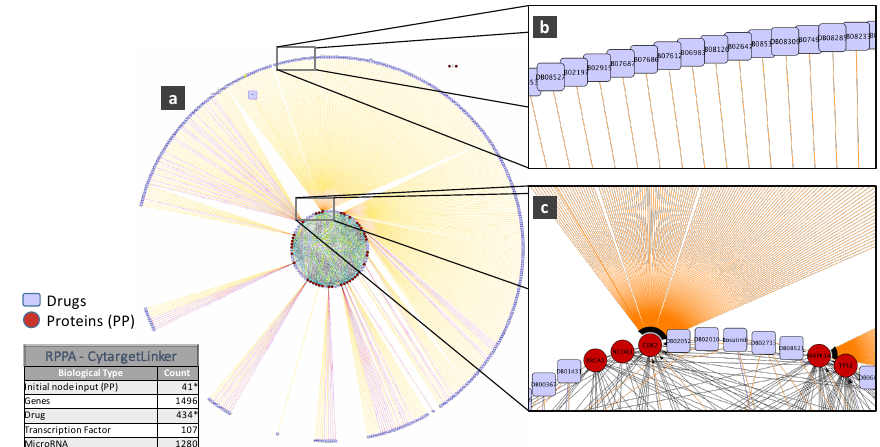
Figure 6. ( a ) Protein and drug interactions among top features selected in the RPPAdata; ( b ) Outer ring showing details of the drug connection with CDK2; ( c ) Inner ring detail showing the CDK2 drug connectivity network from both the inner and outer rings. Images obtained from Cytoscape using the CyTargetLinker App (version 3.0.1). Only the elements marked with an * are displayed in this